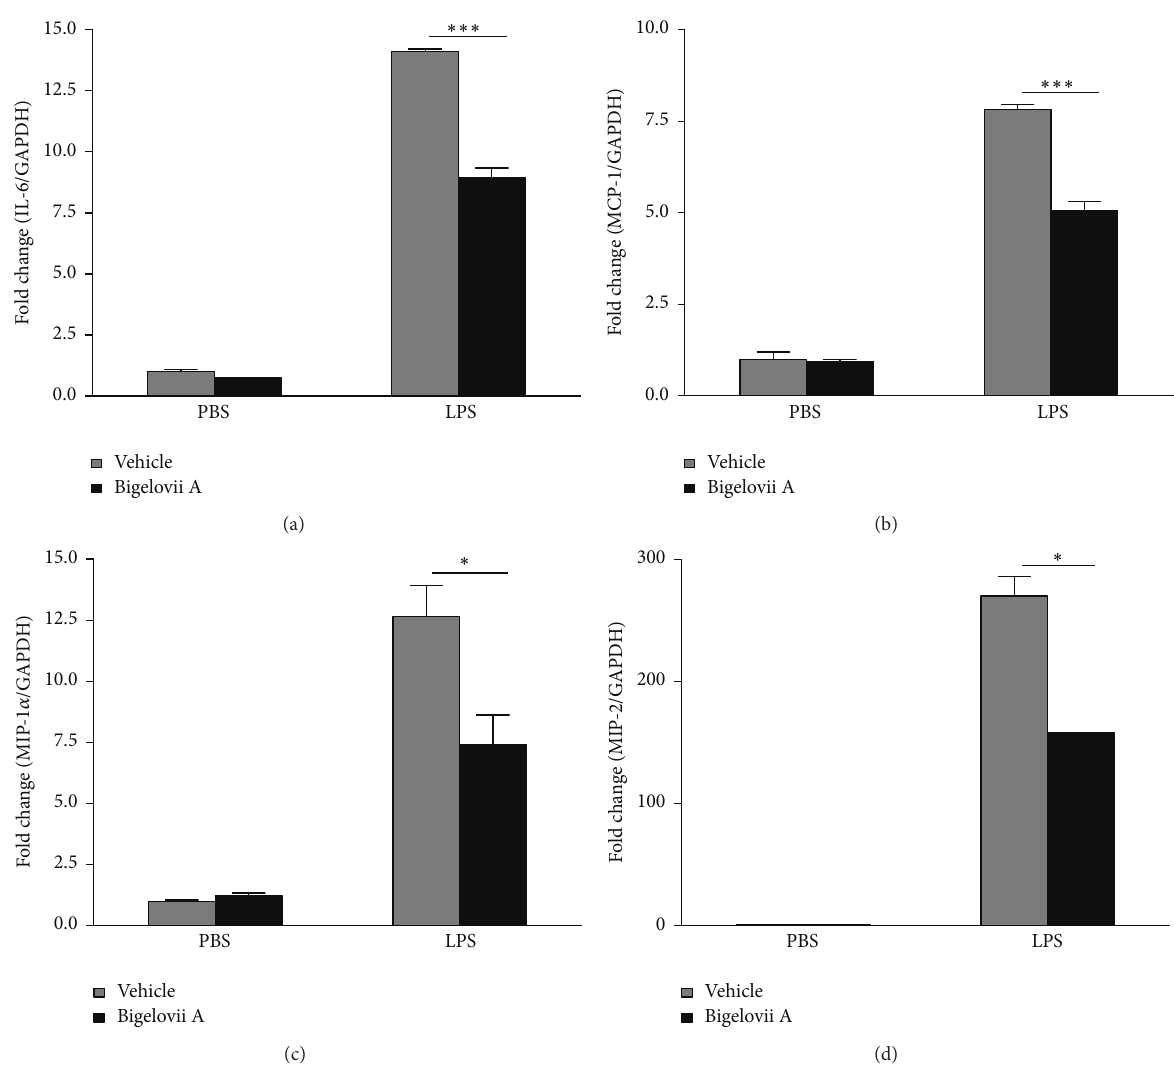
Figure 6: Effect of Bigelovii A on cytokine and chemokine transcription during LPS-induced inflammation in MH-S cells. MH-S cells were pretreated with 10 𝜇 M of Bigelovii A for 1 h, followed by treatment with PBS or 100ng/mL of LPS for 3 h. mRNAs were then extracted. Real time PCR was conducted to measure the mRNA levels of IL-6 (a), MCP-1 (b), MIP-1 𝛼 (c), and MIP-2 (d). Results are reflected by means ± SEM ( 𝑛 = 3 ). ∗ and ∗ ∗ ∗ indicated statistically significant difference, 𝑝 < 0.05 and 0.001, respectively. Negative control: cells treated by Vehicle plus PBS. Positive control: cells receiving LPS plus Vehicle